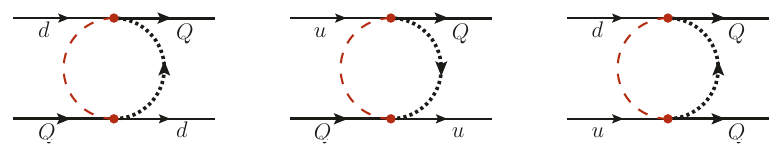
Figure 6 . Representative one-loop Feynman diagrams with ALP exchange (red dashed line), which require operators in the class ψ 4 as counterterms. Analogous graphs exist in the lepton